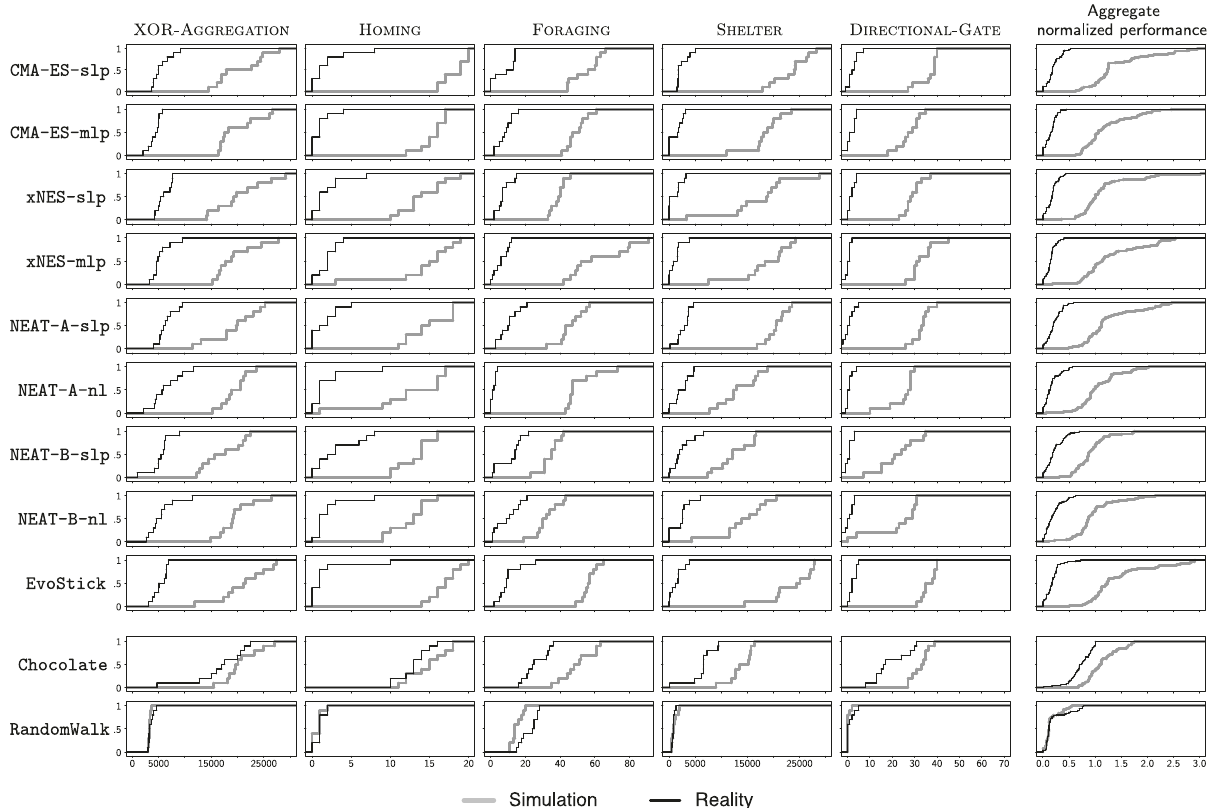
Fig. 5 Distributions. Empirical distribution of the performance of the control software generated by each method under analysis on each of the fi ve mission considered. The last column displays the normalized performance of each method, aggregated across the fi ve missions. Aggregation is performed using the min-max normalization technique described in Methods under the heading Statistics. The black line represents the empirical distribution of the performance observed in real-robot experiments; the gray one, the one obtained in